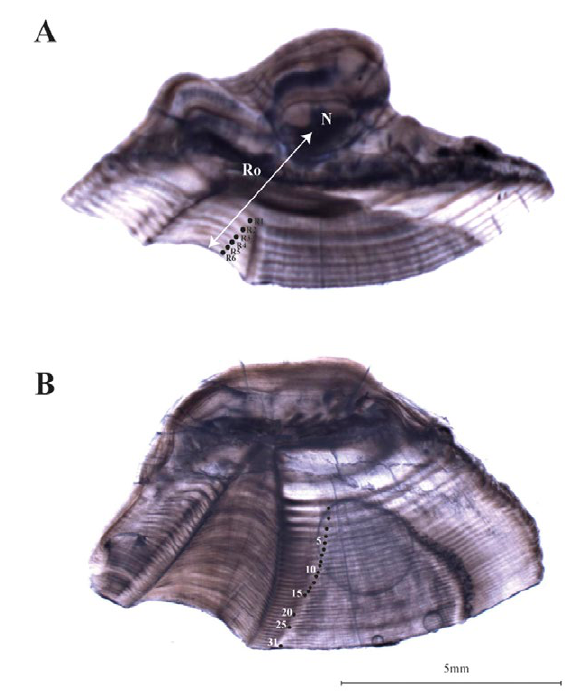
Fig. 1. – Example of otolith cross-sections of Sciaena umbra in the Gulf of Tunis. Individual of 6 years old (TL=36.8 cm, male) (A) and 31 years old (TL=49.2 cm, female)